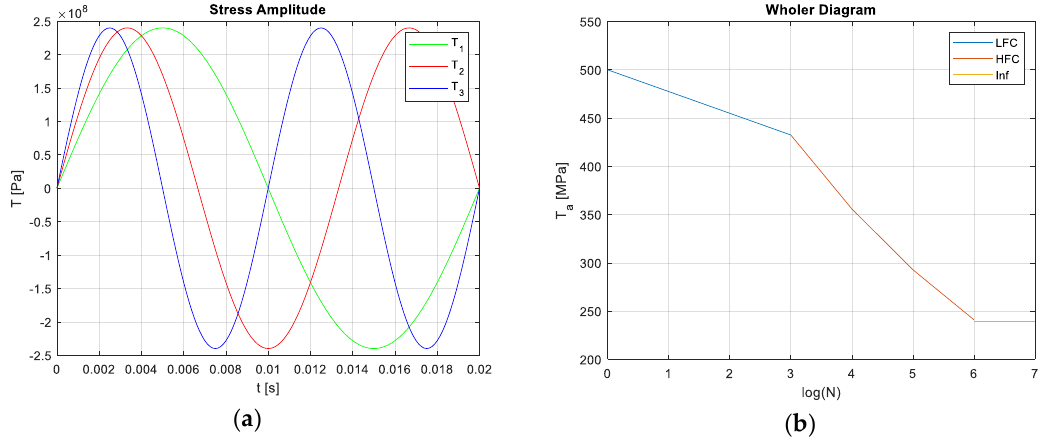
Figure 6. ( a ) Load curves at 50 Hz (T 1 ), at 75 Hz (T 2 ), and at 100 Hz (T 3 ); ( b ) Wh ӧ ler plot of the steel.